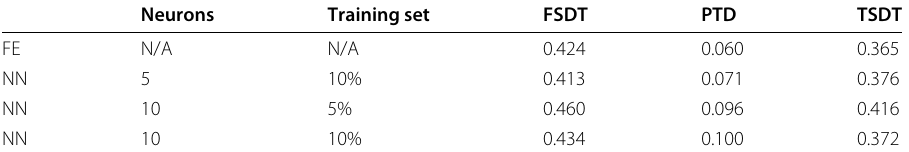
Table 5 0/90/0, a/h = 100, 10% training sets, one layer, influence of the number of neurons on some particular cases from Figs. 5, 6 and 7 Neurons Training